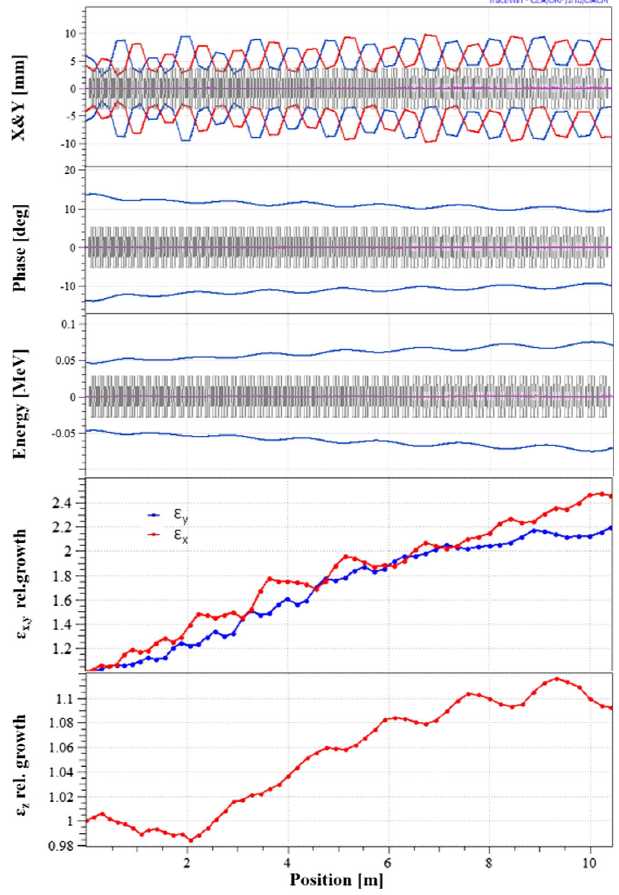
FIG. 6. Beam envelopes, transverse, and longitudinal rms- emittance growth for the unstable case of k 0 ;t ¼ 110 °, k ¼ 120 0 ;z